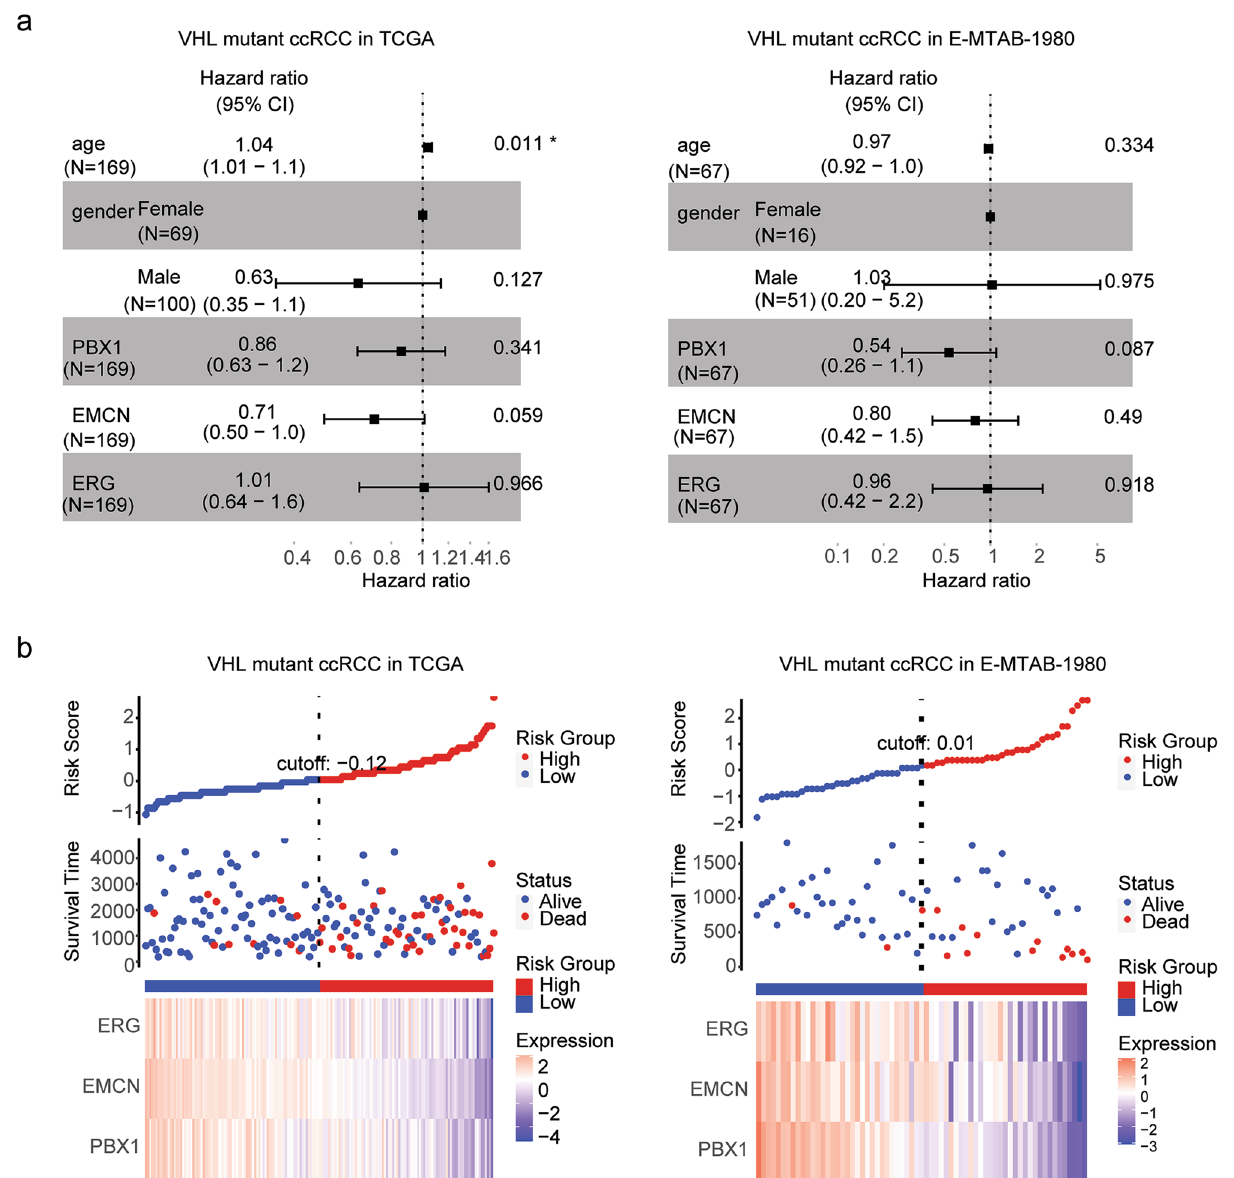
Figure 7. Construction of risk models of VHL mutant ccRCC based on PBX1, EMCN and EGR expressions. ( a ) Forest plots showed the associations of age, gender, PBX1, EMCN and EGR expressions with the clinical overall survival of VHL mutant ccRCC patients in TCGA and E-MTAB-1980 datasets. ( b ) The distribution of risk score, survival status and expression levels of PBX1, EMCN and EGR between low-risk group and high-risk group of VHL mutant ccRCC in TCGA and E-MTAB-1980